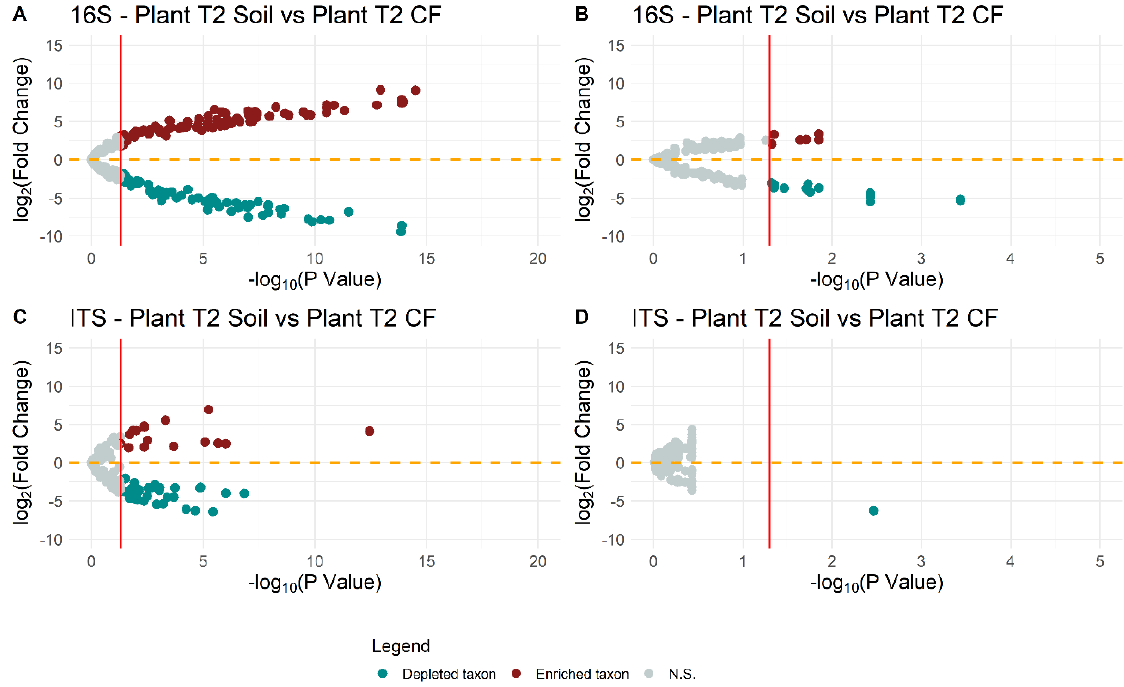
Figure 6. Volcano plots showing differentially abundant bacteria and fungi in rhizosphere ( A , C ) and endorhizosphere ( B , D ), respectively. Negative log-transformed false-discovery rate (FDR) P-values are plotted on the x-axis and log fold change is plotted on the y-axis. The orange dotted horizontal line represents the log fold change cut-off which divides the significant enriched bacteria and fungi (red dots) and the significant depleted bacteria and fungi (blue dots) from the non-significant (grey dots). The red vertical line represents the 1.30 negative cut-off log p -value (which corresponds to the FDR 0.05